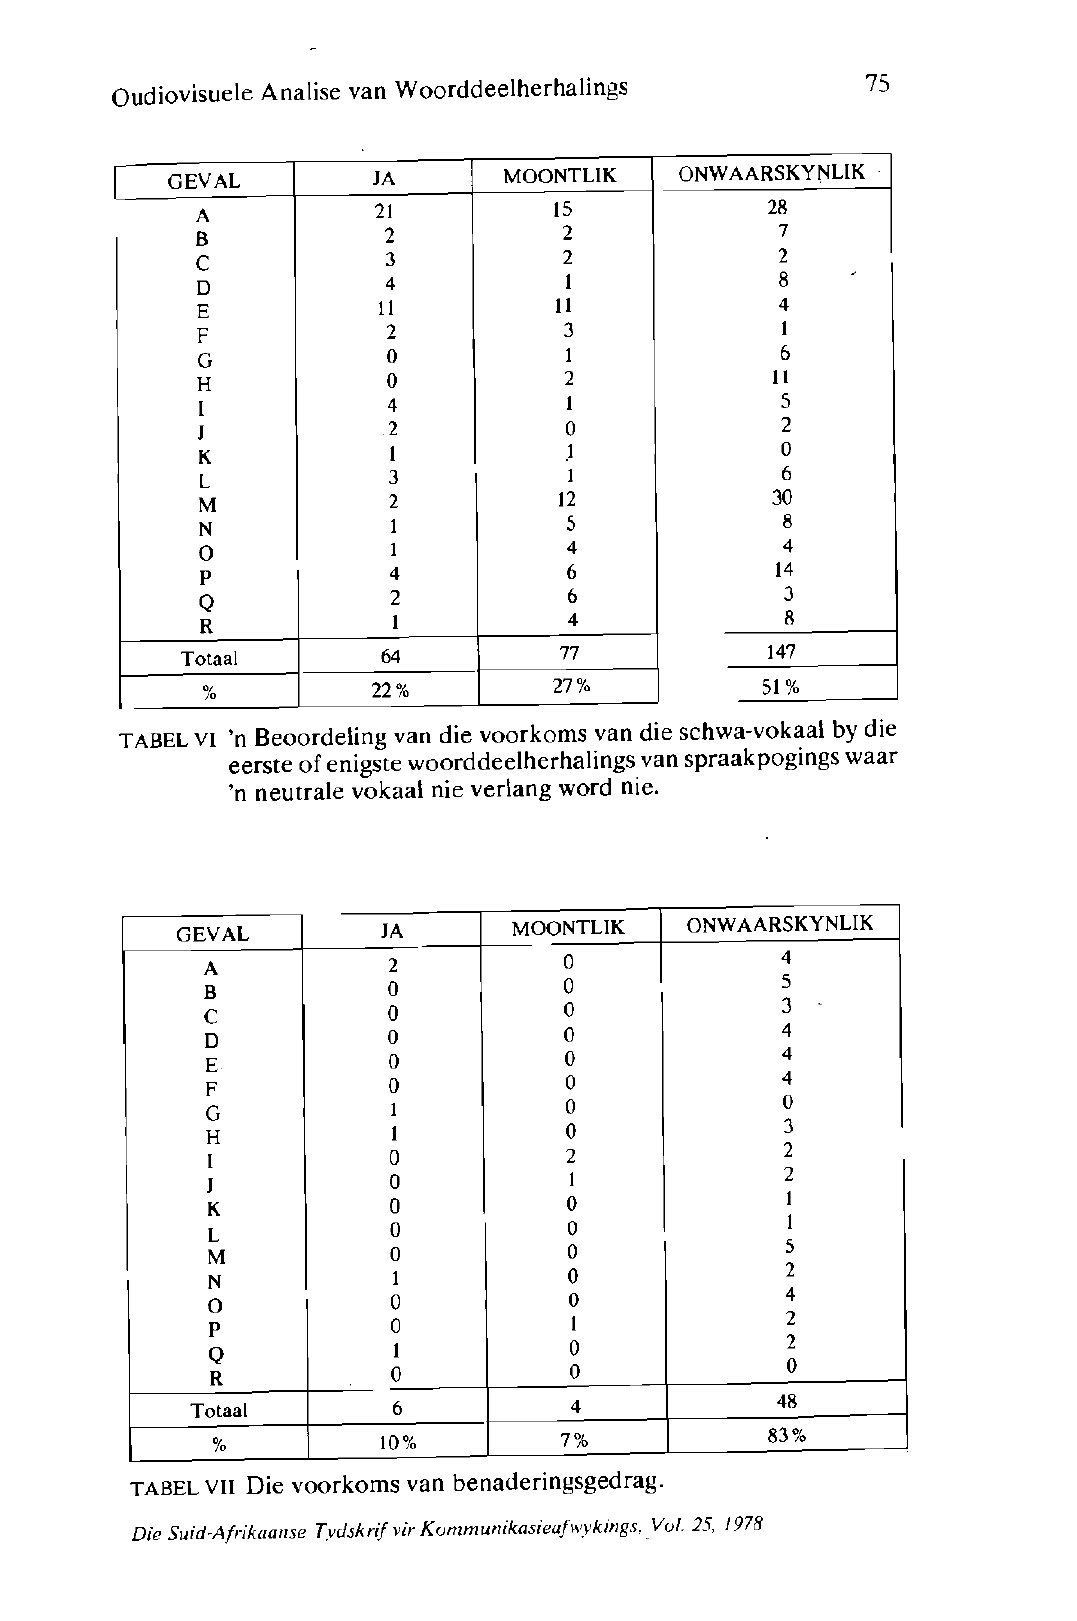
TABEL VII Die voorkoms van